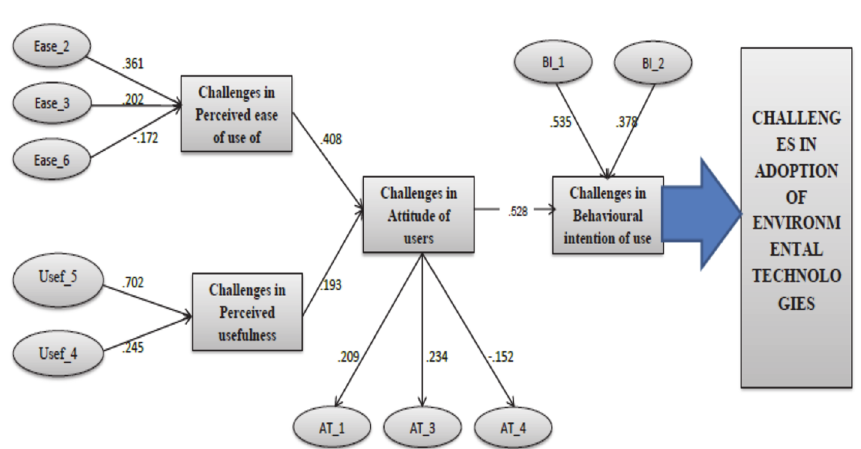
Fig. 3. Challenges in Adoption of Environment Technology in Cement Industry